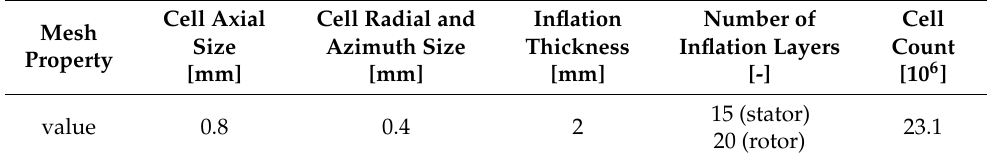
Table 9. The suitably refined mesh for air gaps from Bouafia